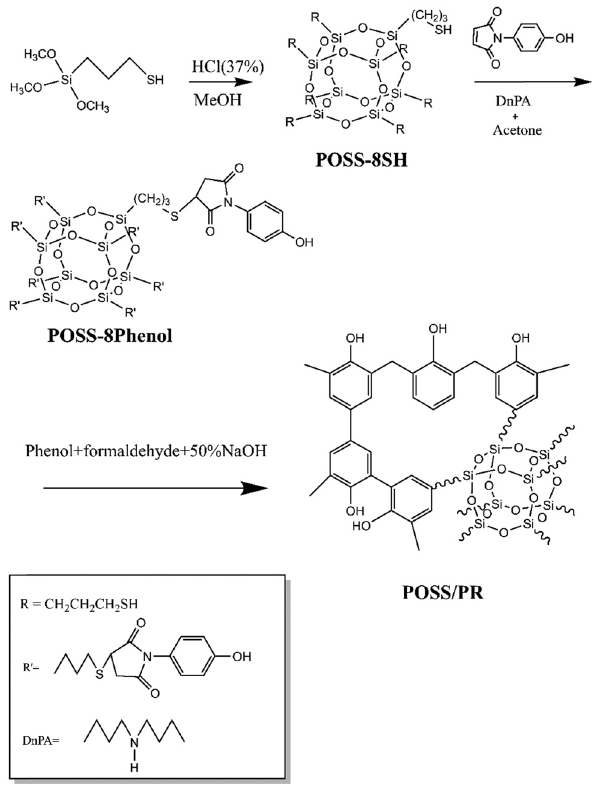
Figure 1: Experimental route and chemical structures of POSS - 8SH, POSS - 8Phenol, and POSS -